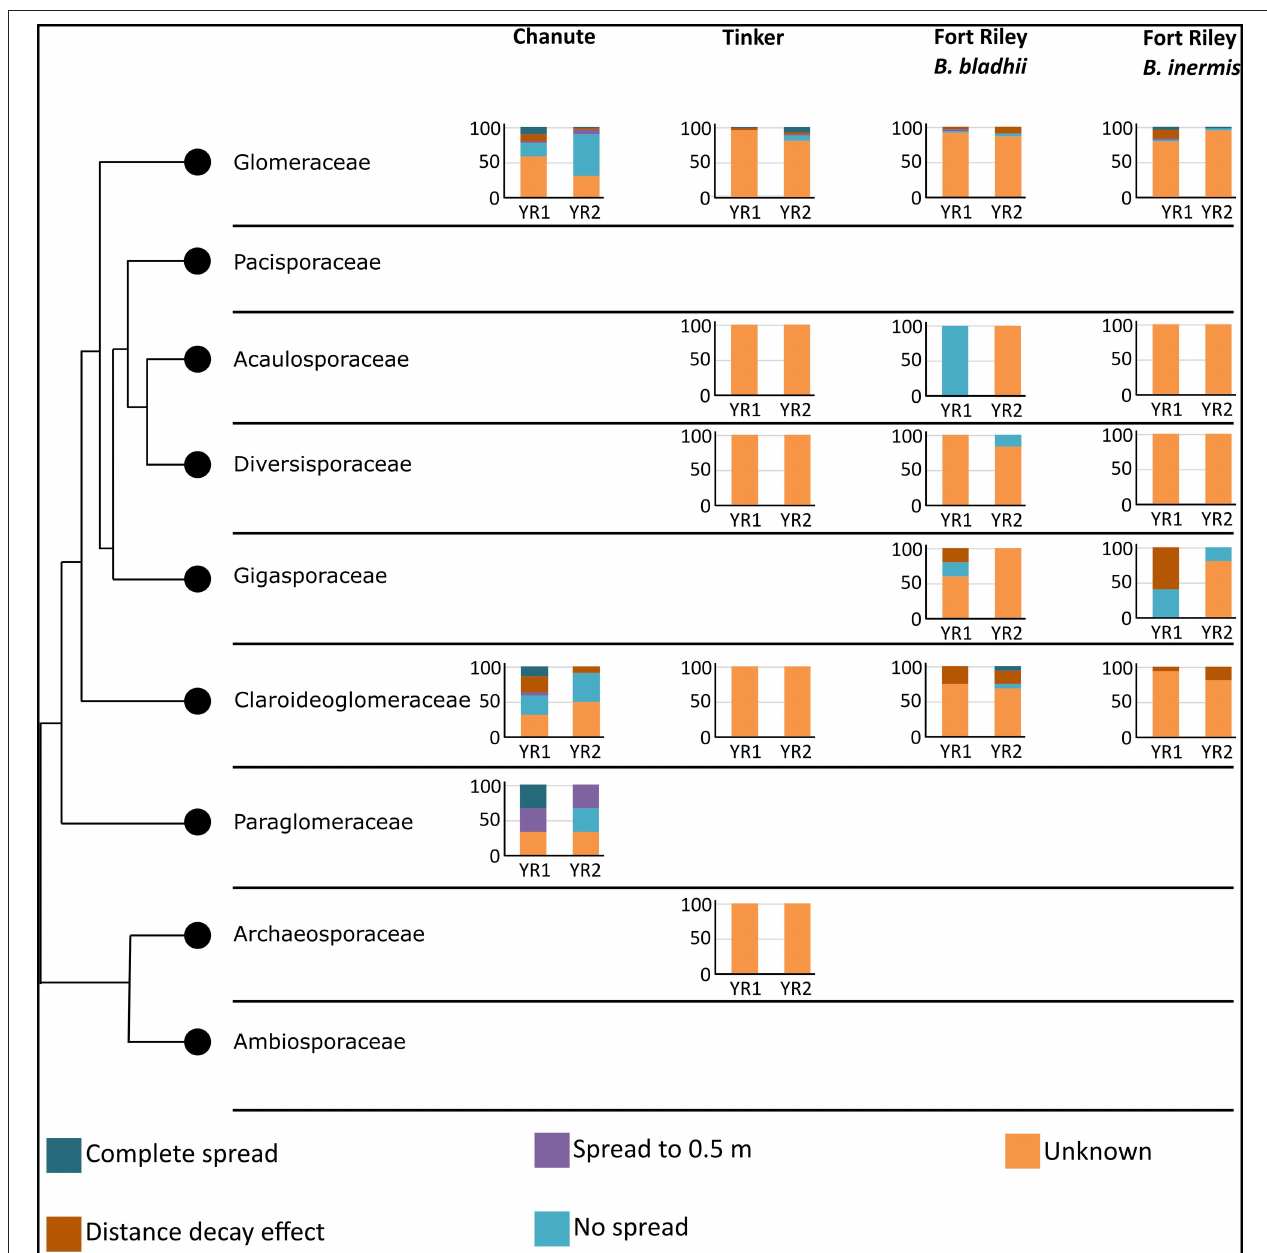
FIGURE 3 | Spread categories by taxonomy. Y-axis represents the percentage of trials in each category. Graphs are broken down into site and year. Colors represent the spread categories.